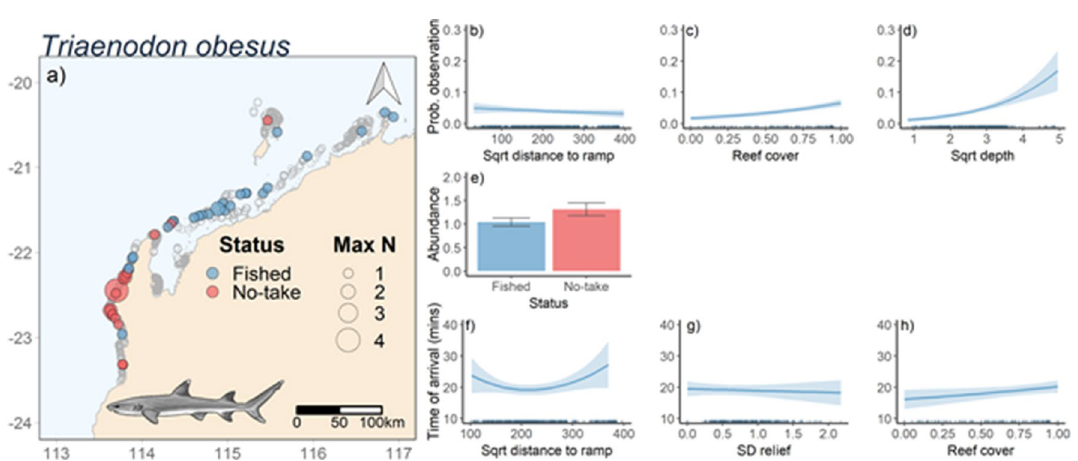
Figure 6. Map of stereo-BRUVS deployments in north-west Australia (indicated by grey open circles. Colour of circles indicates whether the stereo-BRUVS was deployed inside a No-Take Area (red) or in an area where fishing is permitted (Blue). Size of the circle shows the MaxN of Triaenodon obesus in each deployment ( a ). Predicted T. obesus probability of occurrence ( b , c , d ), abundance (MaxN; e ) and time of arrival on BRUVs ( f , g , h ) as functions of variables present in the most parsimonious models (Table 2) from full-subsets GAMM analysis. Ribbons and error bars represent 95% confidence intervals. Figure was generated using R 14 using ggplot2 15 and ggmap 16